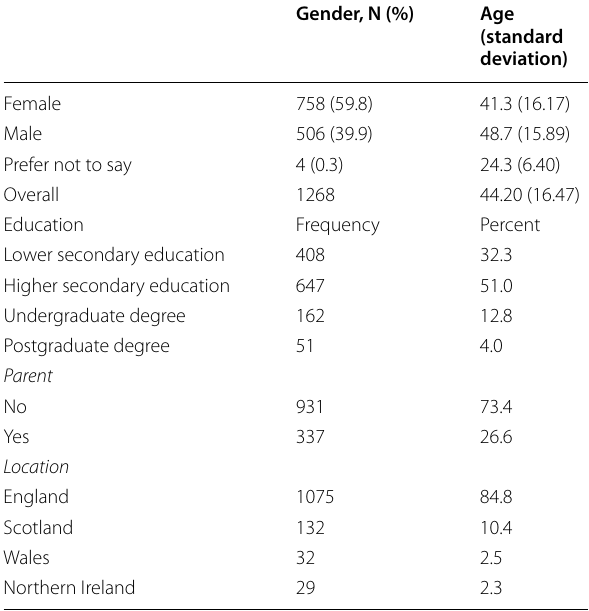
Table 1 Sociodemographic